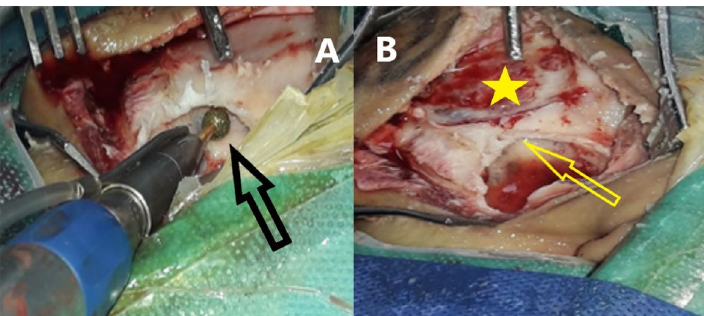
Fig. 1 A Pocket being created in the sinodural angle via coarse diamond burr (black outlined arrow). B Recess drilled (yellow star) to accommodate RS thickness, pocket formed in sinodural angle leaving 2.5–3 cm bridge (yellow outlined